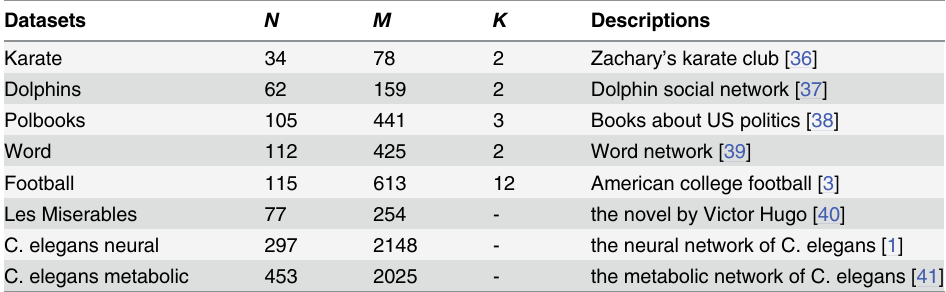
Table 2. Real-world networks used